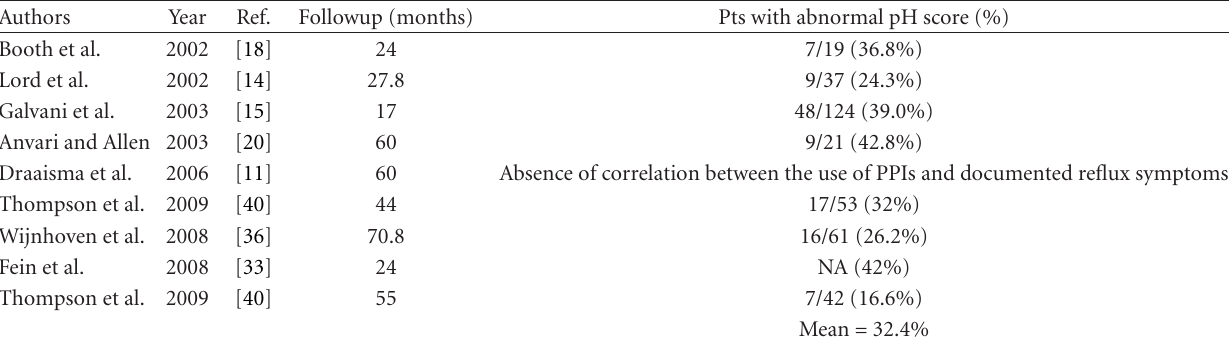
Table 5: Abnormal esophageal exposure to acid in patients taking ARM after